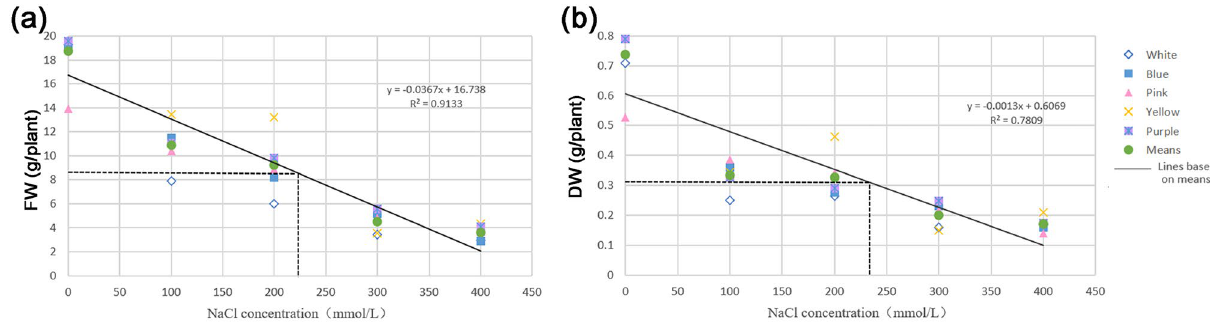
Figure 2. Salt-tolerance thresholds of five varieties of Limonium sinuatum . A 50% reduction in biomass compared to the control was used as the standard to determine the salt-tolerance threshold. ( a ) Changes in fresh weight (FW) of the leaves of five L. sinuatum varieties under different salt treatments. ( b ) Changes in dry weight (DW) of the leaves of five L. sinuatum varieties under different salt